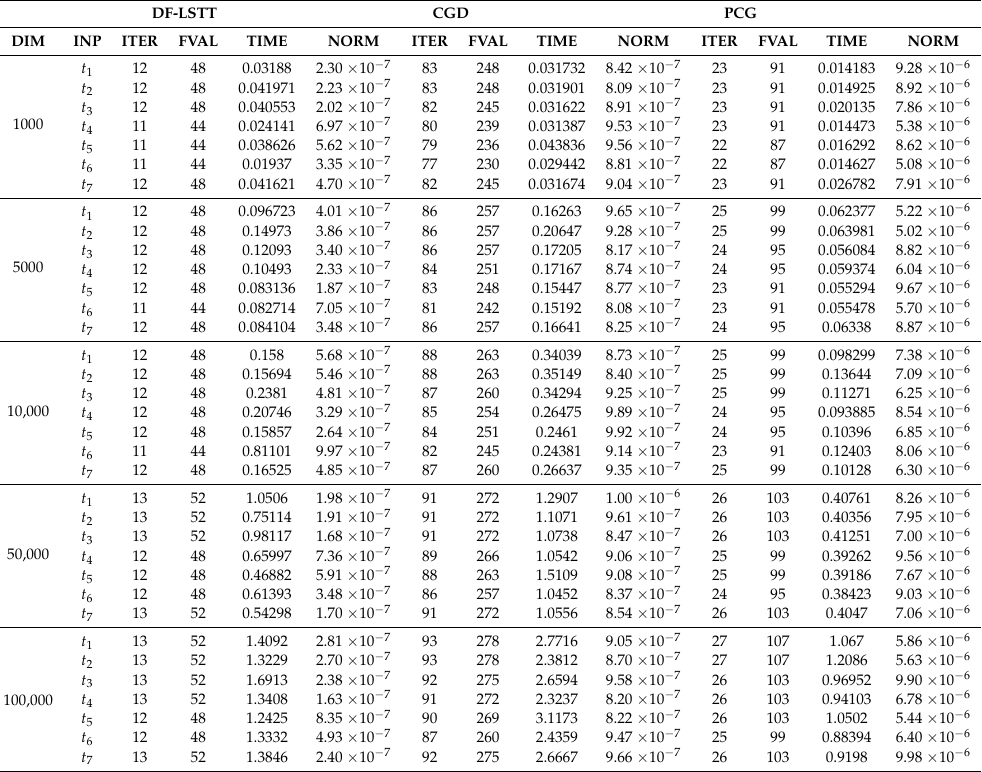
Table 8. Numerical test reports for the three tested methods for Problem 6.